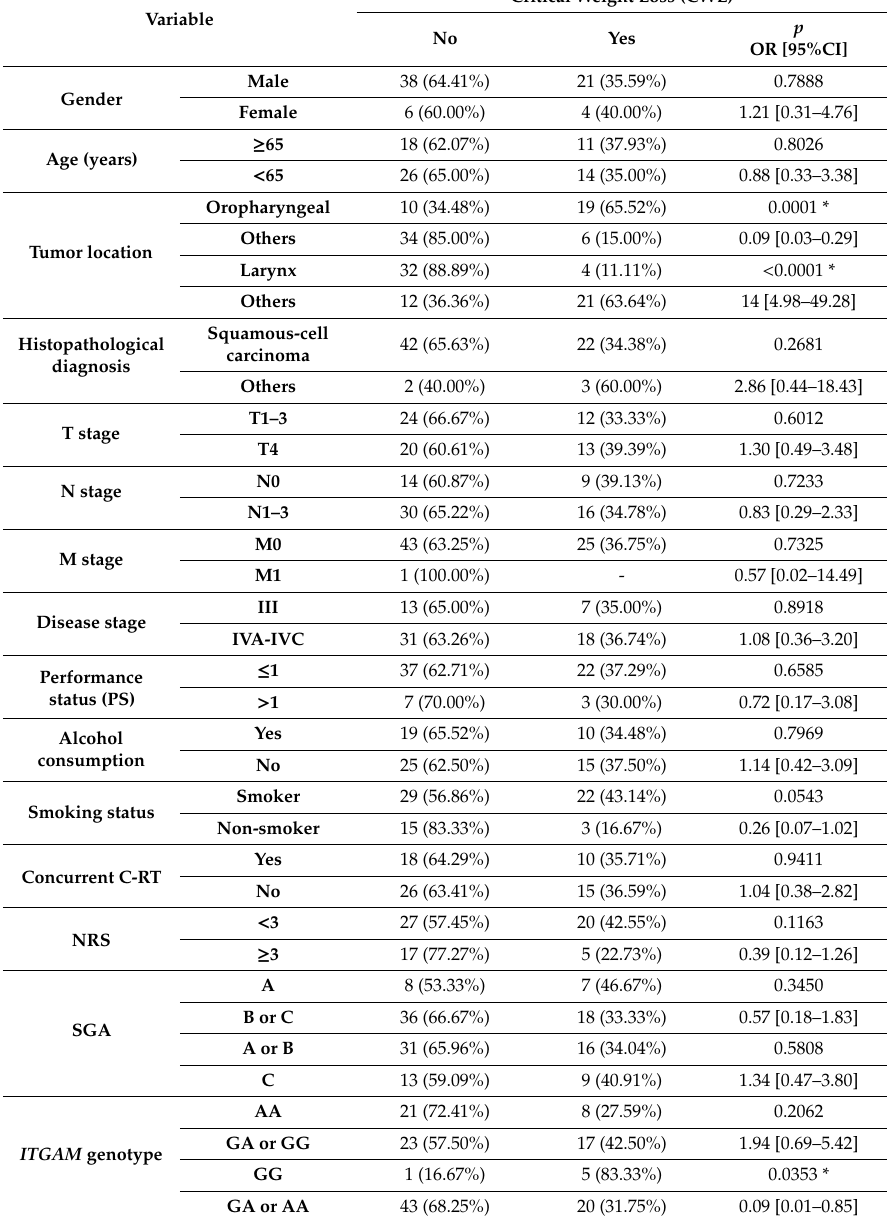
Table 4. Impact of the clinical-demographic, nutritional and genetic factors on the critical weight loss